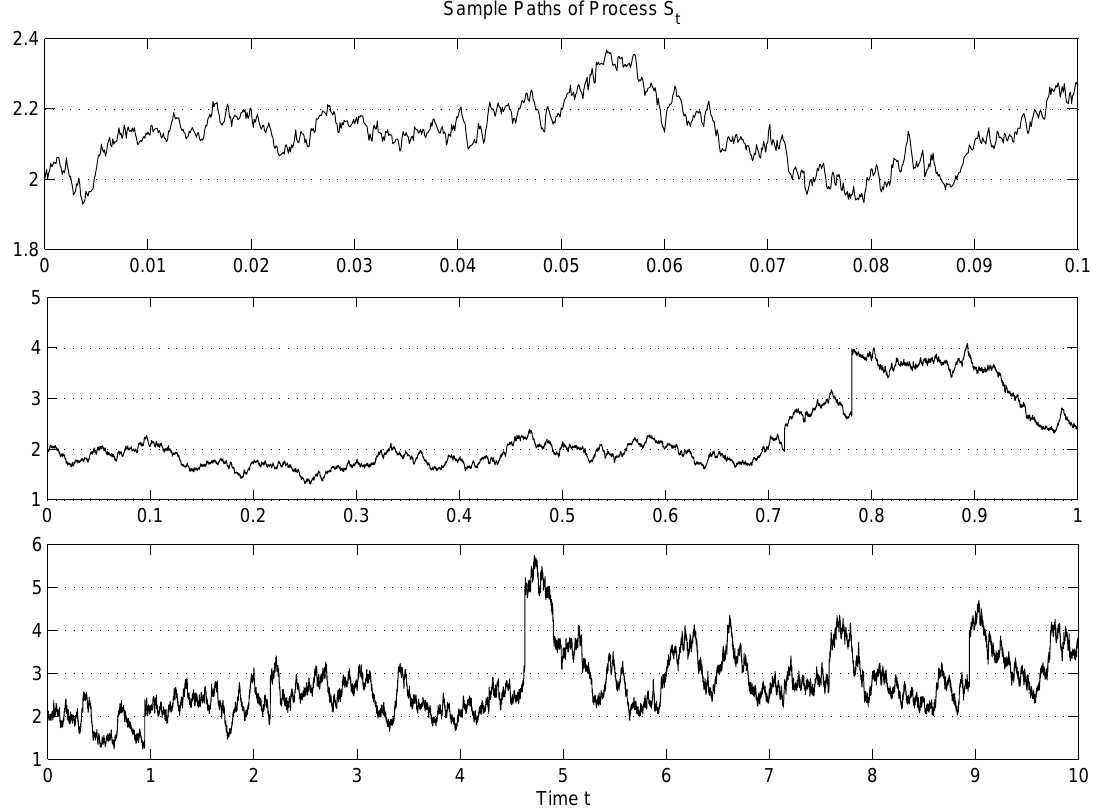
Figure 1. Sample paths of simulated process S t for three different time